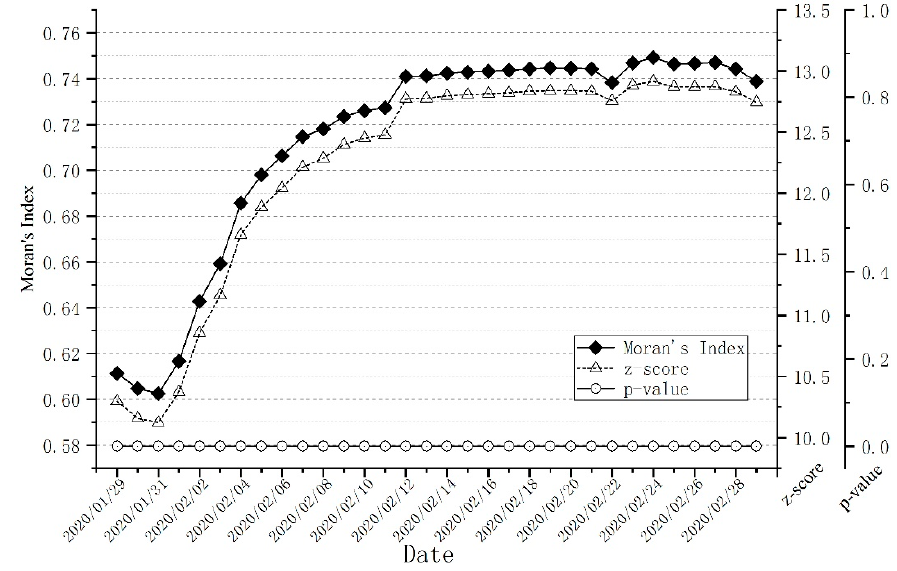
Figure 4. Time-serial spatial autocorrelation of COVID-19.